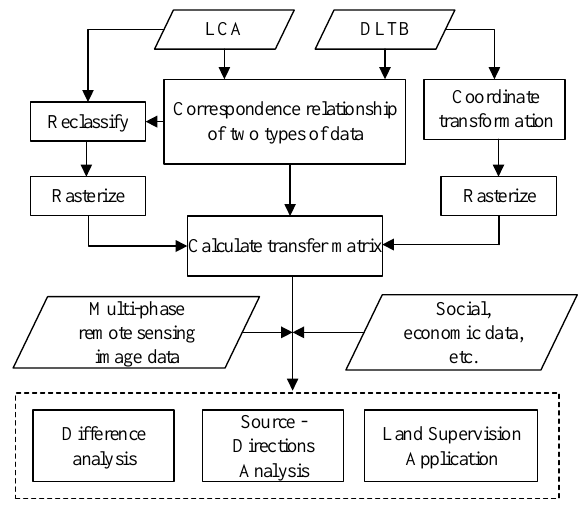
Figure 1. Technical flow